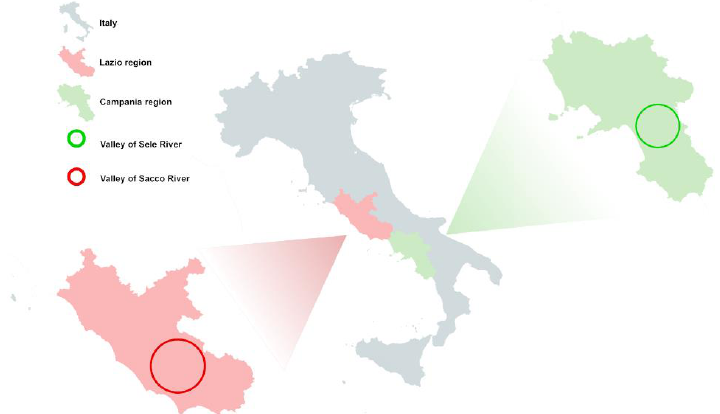
Figure 1. Map of the geographical areas selected for the recruitment. The green circle indicates the Valley of Sele River in the Campania region; the red circle indicates the Valley of Sacco River (VSR) area in the Lazio region. The green and red circles indicate the geographical position of the two areas in the respective regions.